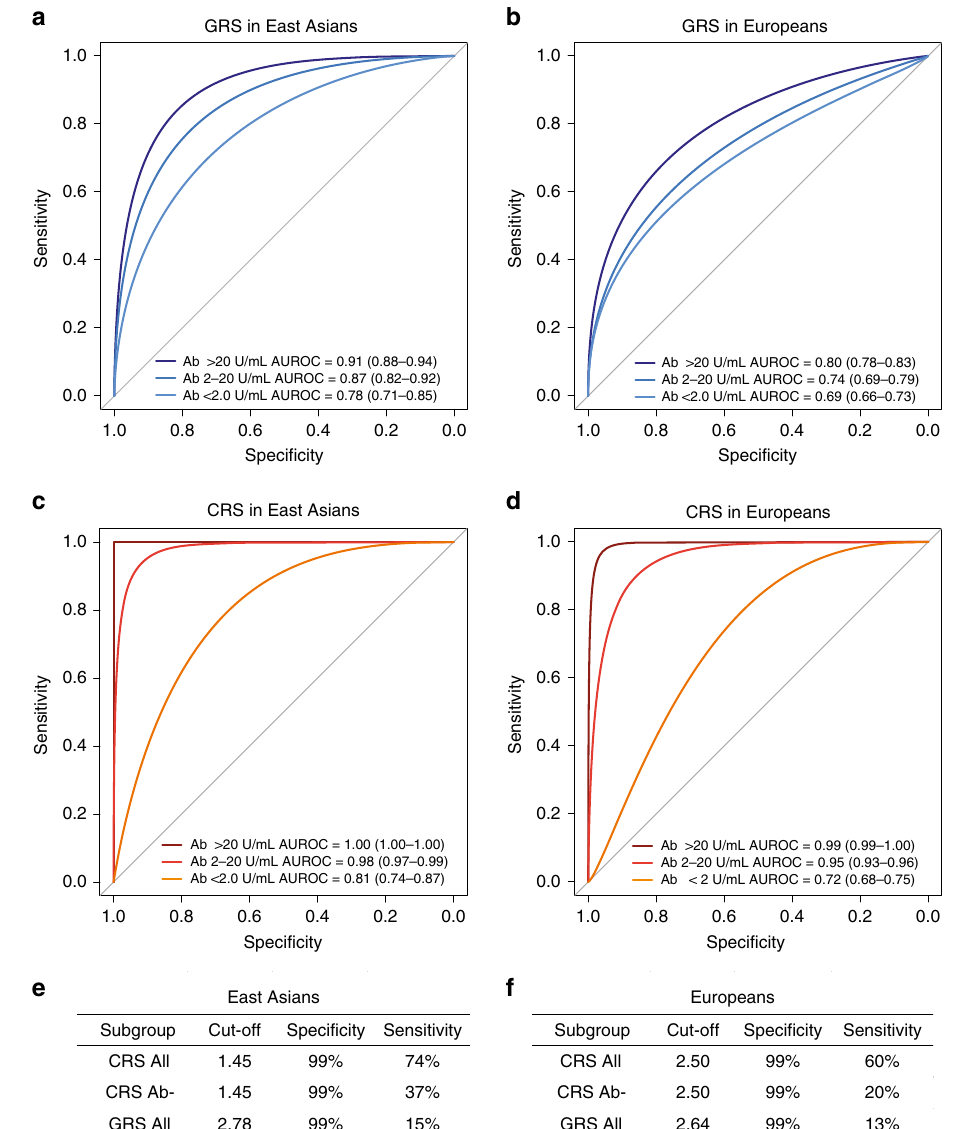
Fig. 7 Diagnostic properties of the genetic risk score (GRS) and combined risk score (CRS) strati fi ed by anti-PLA2R antibody status. Comparisons of receiver operating characteristic (ROC) curves to discriminate antibody positive (PLA2R Ab > 20 U/mL), borderline negative (PLA2R Ab 2 – 20 U/mL), and negative (PLA2R Ab < 2 U/mL) cases of primary MN from all available healthy and diseased controls combined for a GRS in East Asian discovery cohorts, b GRS in European discovery and validation cohorts, c CRS in East Asian discovery cohorts, d CRS in European discovery and validation cohorts. Overall sensitivities for risk score cut-offs corresponding to 99% speci fi cities in ( e ) East Asian discovery cohorts and ( f ) European discovery and validation cohorts; CRS All: all patients with serum Ab measurements by ELISA within 6 months of a diagnostic kidney biopsy; CRS Ab-: patient subgroup with PLA2R Ab < 20 U/mL, and GRS All: all patients with GWAS data available for GRS calculation. AUROC: area under the ROC curve (95% con fi dence